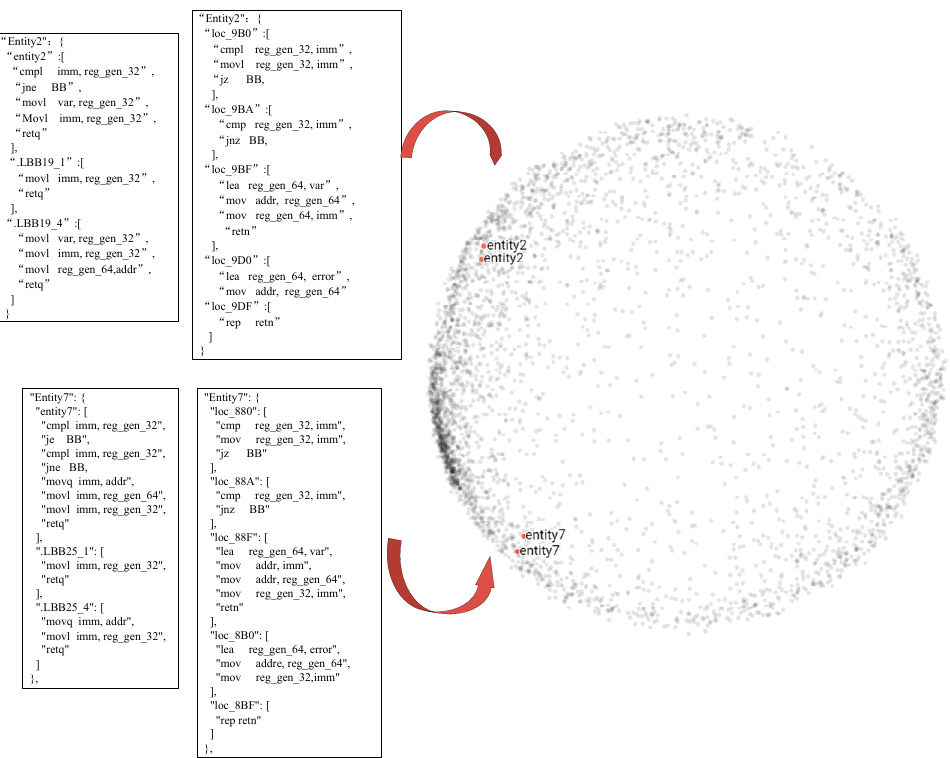
Figure 1. Assembly function embedding vector space T-SNE visual distribution. The classical functions Entity2 and Entity7 in the OpenSSL project were selected as examples. The function vectors of aligned assembly generated by homologous assembly should be close, whereas the function vectors of unaligned assembly should be far apart and distributed discretely.